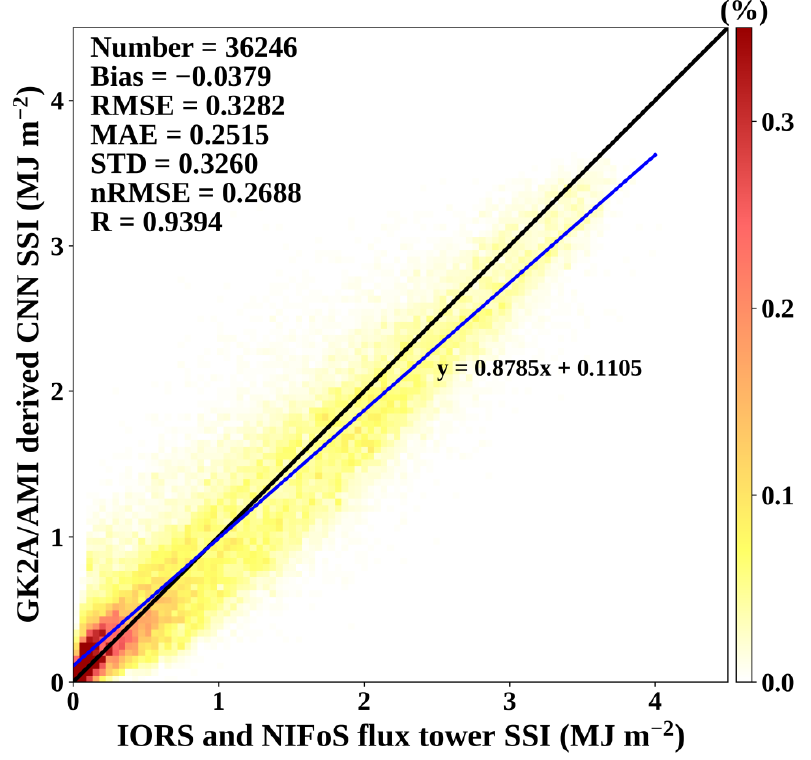
Figure 8. Validation result of the estimated SSI from GK2A/AMI and ground-based SSI measurements from IORS and NIFoS flux towers for the period from 1 August 2020 to 31 January 2022, with the CNN model as the reference model; the color indicates the point density relative to the total matchups; the blue line indicates the regression line.